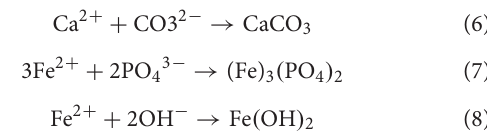
FIGURE 10 | Changes of R p values from EIS data in the Figure 8 in the absence and presence of SRB. (Error bars represent standard deviations).